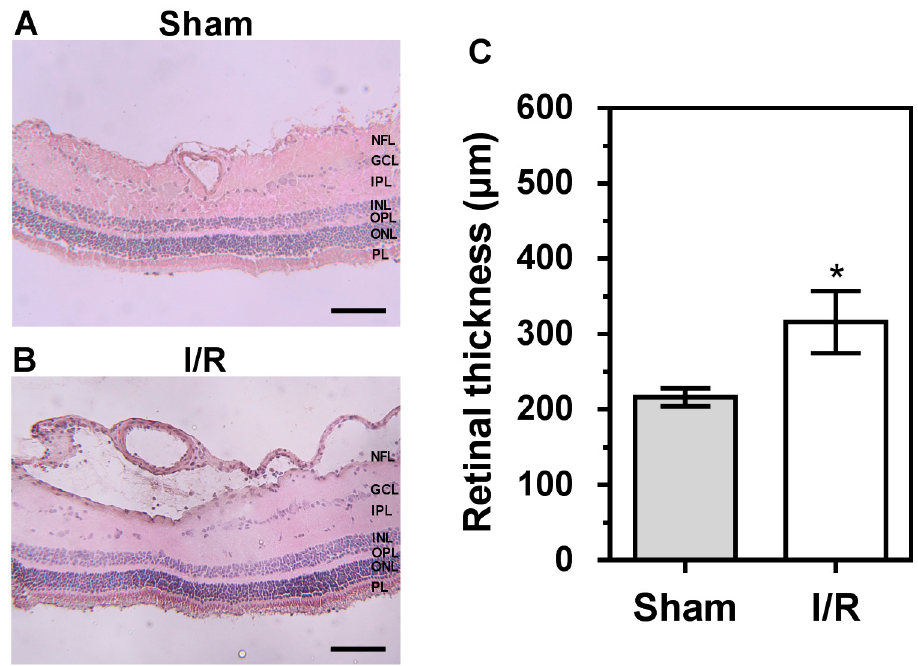
Figure 8. Photomicrographs of retinal cross-sections (H&E staining) from sham-treated ( A ) and I / R- treated pigs ( B ). Quantification of retinal thickness in cryosections revealed increased thickness in I / R-treated pigs ( C ). Data are presented as mean ± SE ( n = 6 per group; * p < 0.05). NFL = nerve fiber layer; GCL = ganglion cell layer; IPL = inner plexiform layer; INL = inner nuclear layer; OPL = outer plexiform layer; ONL = outer nuclear layer; PL = photoreceptor layer. Scale bar = 100 µ m.